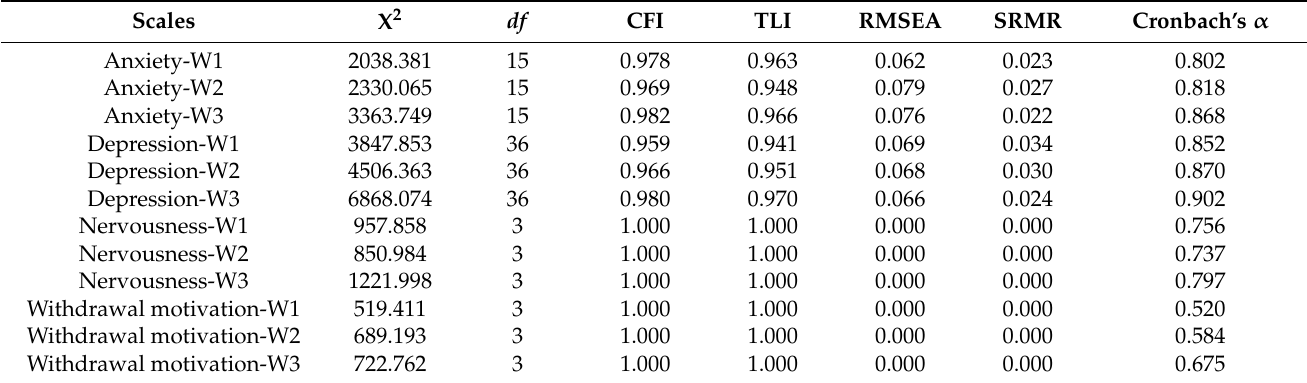
Table 2. Psychometric characteristics of Internalizing